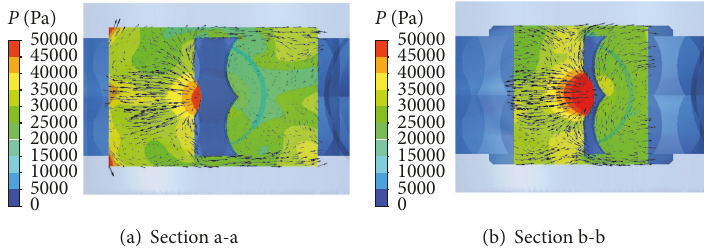
Figure 23: Static pressure distributions and absolute velocity vectors of Blade A ( 𝜃 ∗ = 36 ∘ , 𝑛 = 150 ,000 min −1 ).